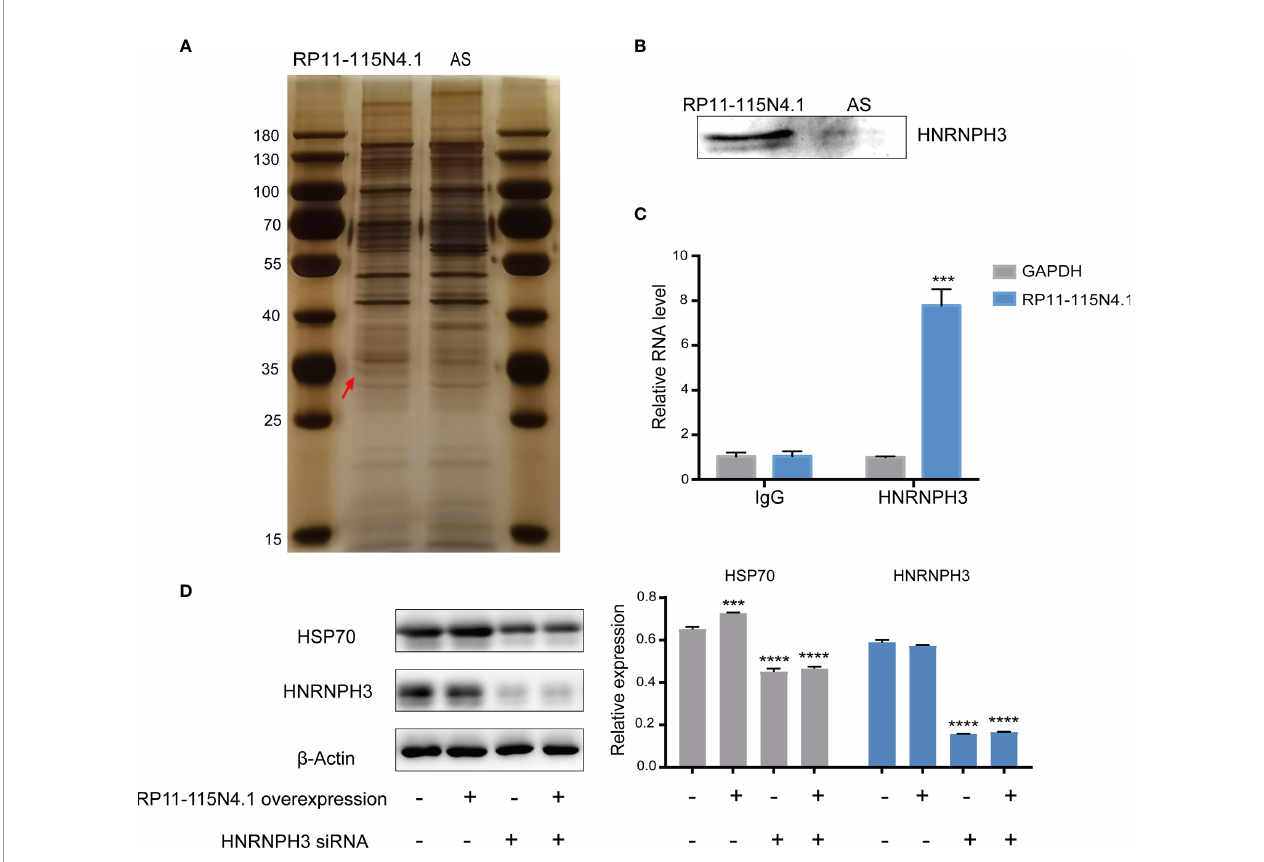
FIGURE 4 | RP11-115N4.1 promoted HSP70 expression by interacting with HNRNPH3. (A, B) RNA-pull-down assay to identify RP11-115N4.1 binding protein in K562 cells. The eluted proteins were separated by SDS-PAGE and subjected to silver staining. Antisense RNA to RP11-115N4.1 (AS) was used as a negative control. The red arrow indicates the band representing the RP11-115N4.1-speci fi c binding protein identi fi ed by mass spectrometry as HNRNPH3. Western blot analysis con fi rmed that RP11-115N4.1 interacts with HNRNPH3. (C) RIP assay was performed using normal mouse IgG or the anti-HNRNPH3 antibody. GAPDH was used as the negative control. (D) Western blot of HSP70 and HNRNPH3 in K562 cells under different condition. b -Actin was used as an internal control. *** P < 0.001, **** P < 0.0001. Each experiment was repeated three times and results are means ±